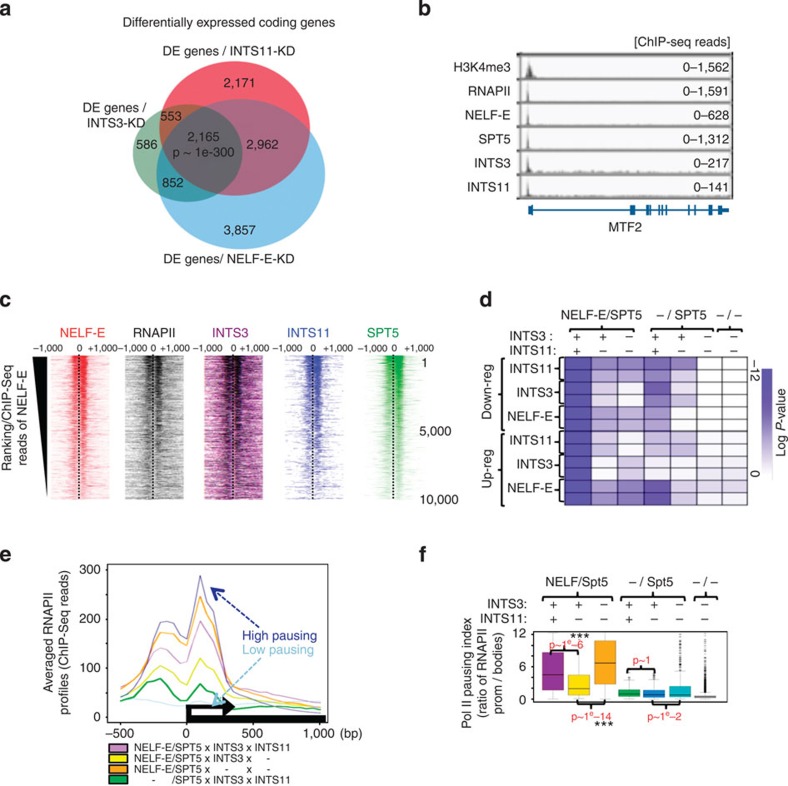
Integrator complex regulates NELF-mediated RNAPII pausing at coding genes.(a) Venn diagram showing the intersection among differentially expressed (DE) genes identified by microarray analysis (n=3) upon depletion of −INTS11, −INTS3− or −NELF-E (see Methods; P<0.001). (b) Genomic view of ChIP-Seq data over the protein coding MTF2 gene for: H3K4me3, total RNAPII, NELF-E, SPT5, INTS3 and INTS11. (c) Heat maps showing the binding of NELF-E, RNAPII, INTS3 and INTS11 by ranking the top 10,000 genes according to NELF binding (+/− 250 bp from TSSs; see Methods). (d) Heat map showing the intersection analyses between DE (down- or up- regulated) genes and the corresponding TSS bound or not (+/−) by NELF-E, INTS3 and INTS11 (see Methods). Differential expression (DE) was analysed in R using limma (adjusted P<0.01; see Supplementary Dataset 2B–D; see Methods). The enrichment between these two lists is indicated in Log P-value (see colour bar). (e) Averaged RNA RNAPII profiles as measured by ChIP-Seq as a function of NELF-E-, Spt5-, INTS3 and INTS11 binding. The ChIP-Seq profiles of ‘High/Low pausing’ are indicated for comparison (RNAPII profiles of highly paused (blue line)- or active genes (light blue line), respectively, as previously described22). Genes bound by −NELF, SPT5 and INTS3 with or without INTS11 (purple and orange line, respectively) or by −NELF and SPT5 with or without INTS3 (yellow and orange line, respectively) or by SPT5, INTS3 and INTS11 (green line). (f) Box plots showing the RNAPII pausing indices depending on NELF/SPT5/INTS3 and INTS11 binding or not (+/−) to the corresponding TSS. P-values, Wilcoxon pair-wise test (see also Supplementary Fig. 7A).